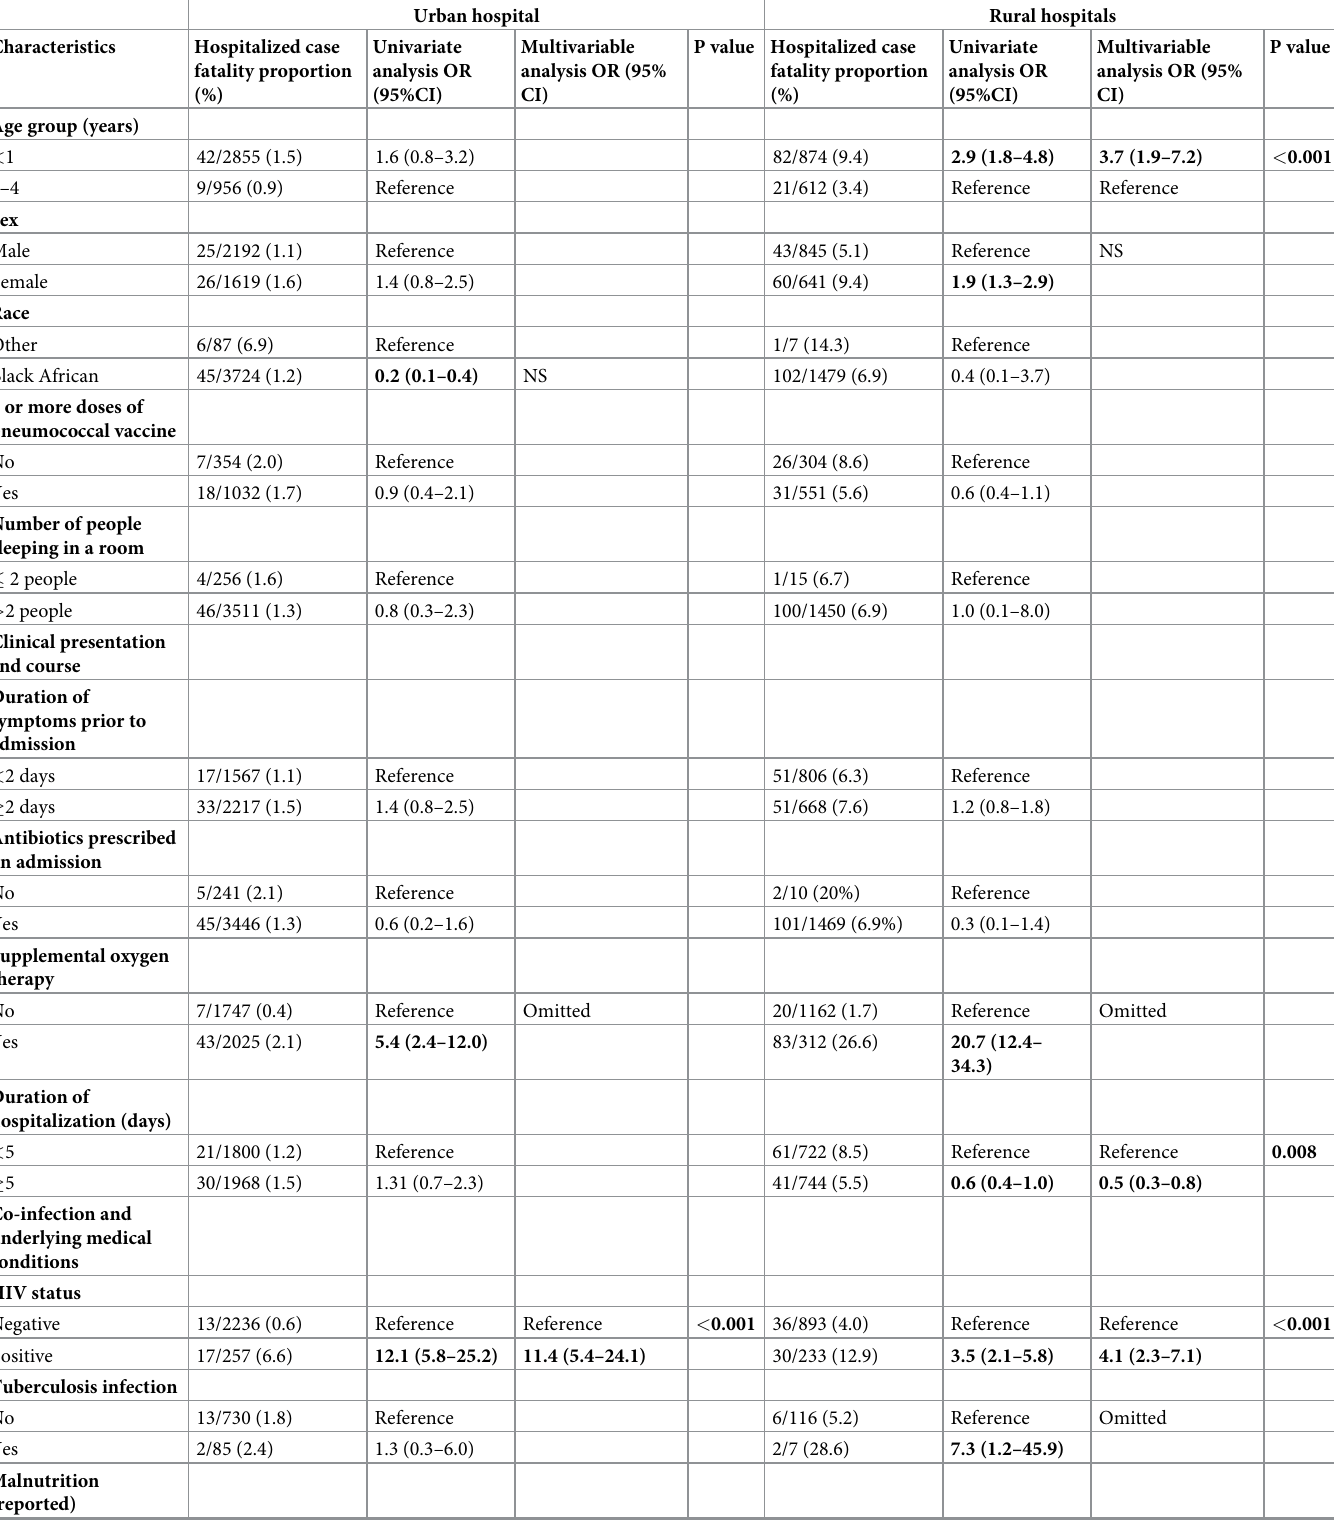
Table 4. Factors associated with in-hospital death among children aged < 5 years hospitalized with SARI at urban and rural hospitals, South Africa 2009–2013.